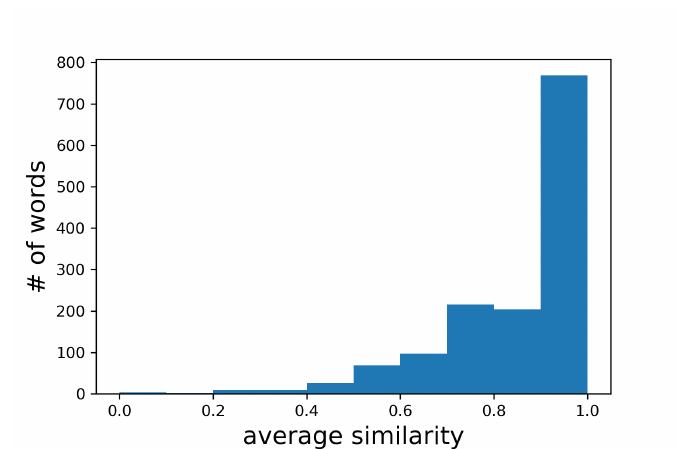
Figure 11. Average similarity between F old